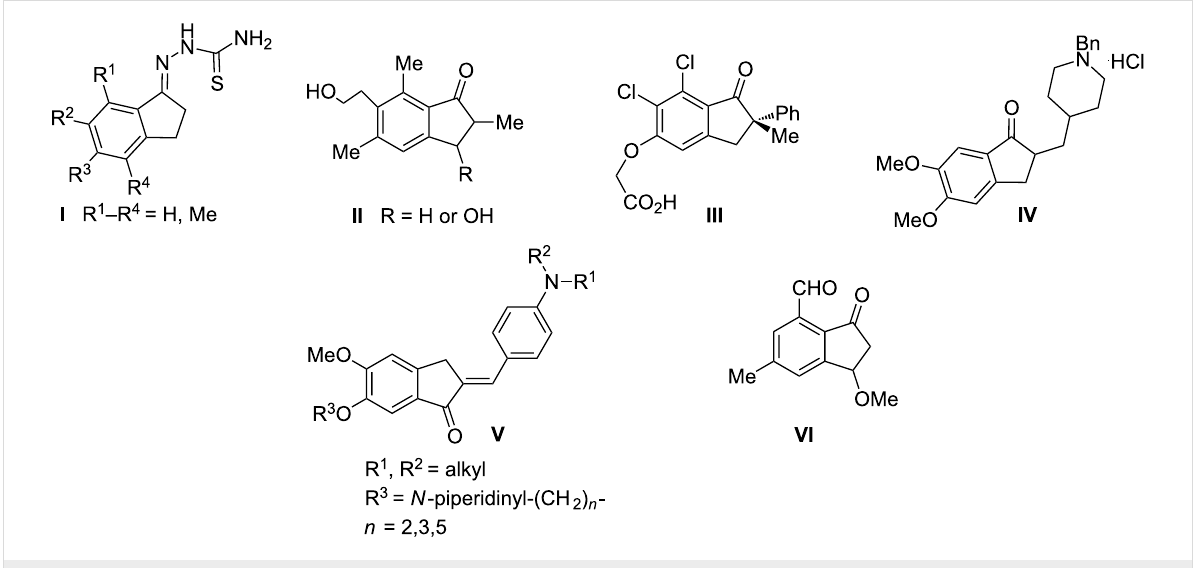
Figure 1: Biologically active 1-indanones and their structural analogues.